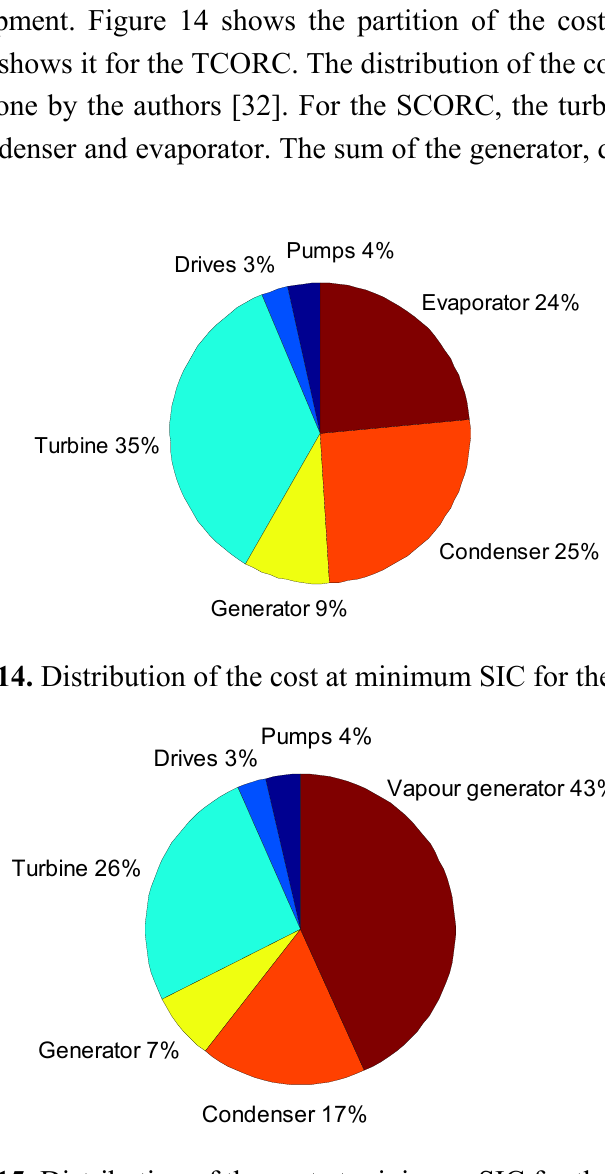
Figure 15. Distribution of the cost at minimum SIC for the